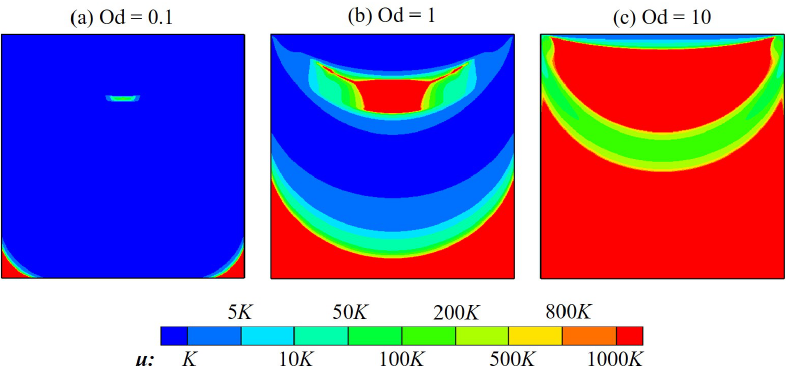
Figure 10. Viscosity distribution of the polymer flow in a square cavity at various Od